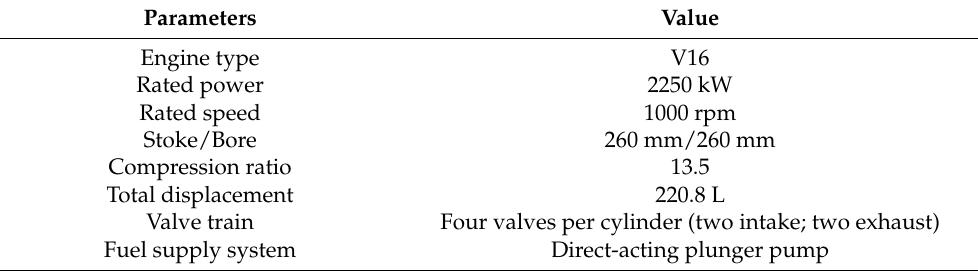
Table 1. Specifications of the investigated diesel engine